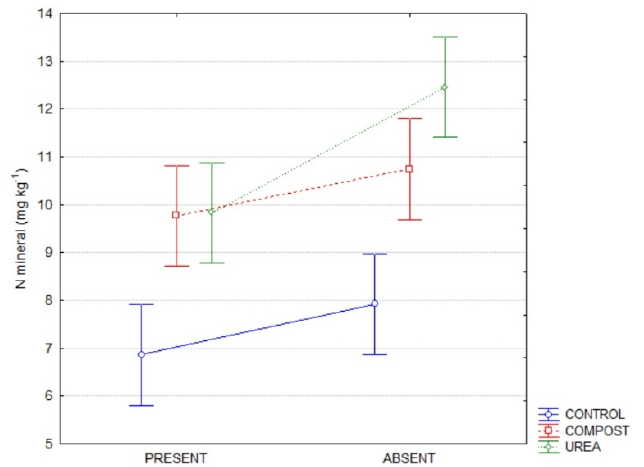
Figure 1. N mineral content in soil with peach trees and submitted to urea and organic compost application, after 180 days of cultivation, in Paspalum notatum presence and absence. Two-way ANOVA. Tukey test at 5% probability. The values presented are averages of three replicates per treatment and the vertical bar represents the standard error.